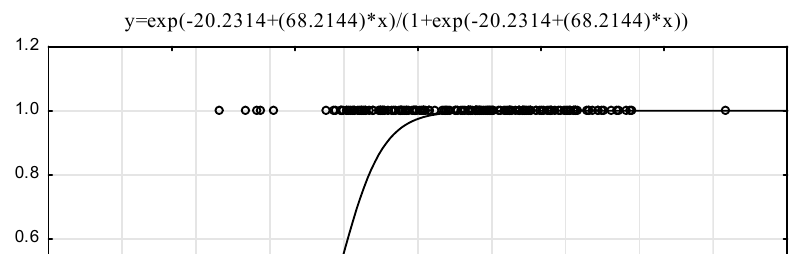
The logit function plot is presented in Figure 5, and the model parameters are shown in Table 4.